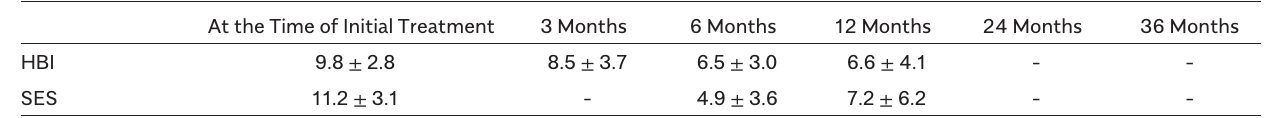
Table 2. International Scores for Crohn’s Disease At the Time of Initial Treatment